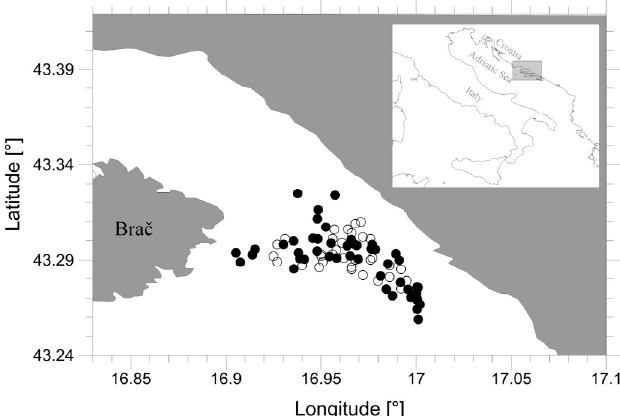
Fig. 1. Map of the survey area showing the position of the creel longlines with one day (solid circles) and two day soak times (open